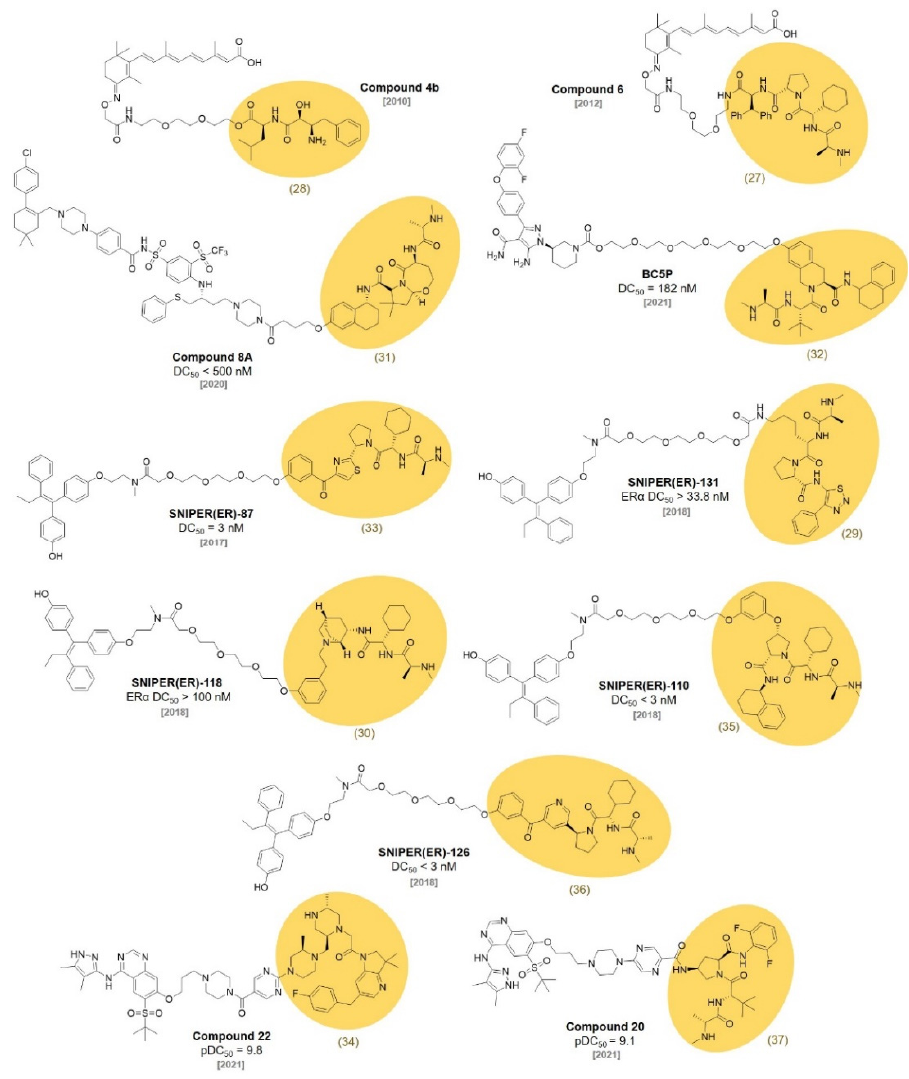
Figure 8. Selected examples of IAP ligand-based PROTACs.